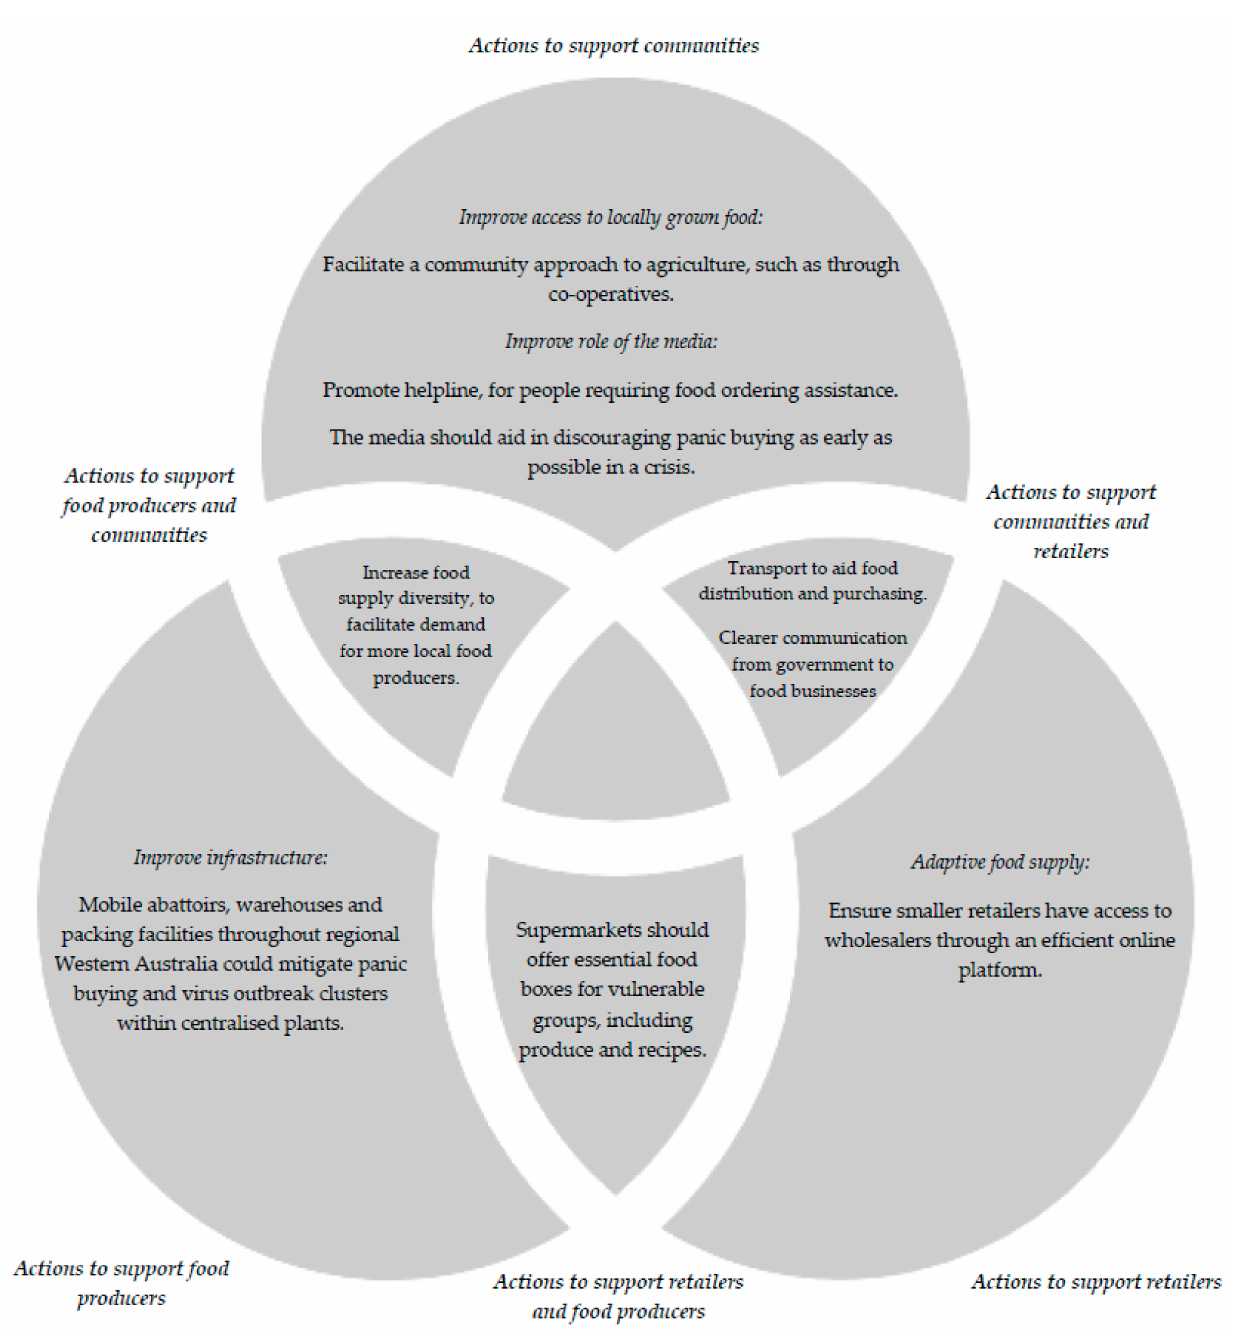
Figure 2. Food producer, community and retailer recommended actions to prepare the South West region for future